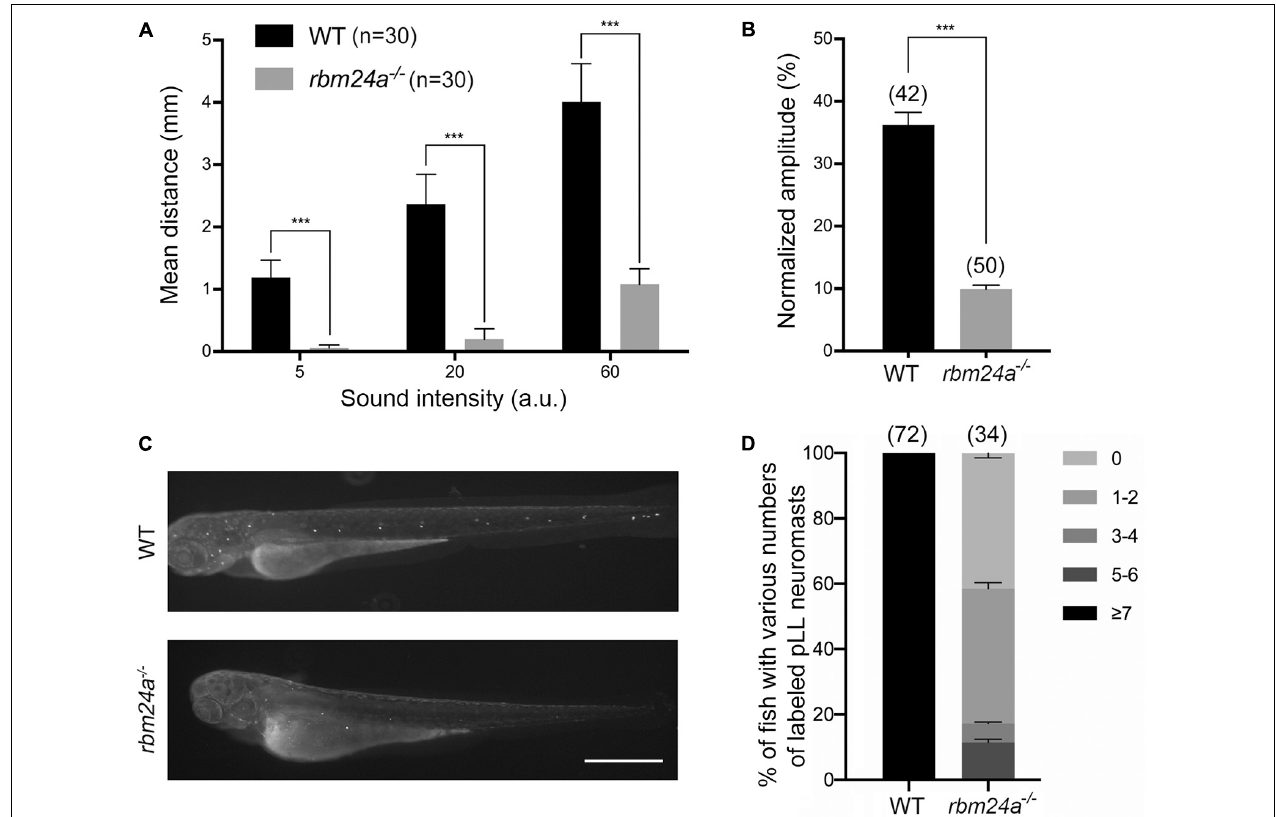
FIGURE 2 | Hair cell function is affected in rbm24a mutants. (A) The auditory function of zebrafish larvae at 5 dpf is evaluated by examining the startle response to various sound intensity. *** p < 0.001. (B) The vestibular function of zebrafish larvae at 5 dpf is evaluated by vestibular head tilt response measurement. *** p < 0.001. (C) The function of hair cells is evaluated by performing FM1-43FX uptake experiment at 3 dpf. Scale bar, 0.5 mm. (D) The numbers of labeled pLL neuromasts per larvae are calculated according to the results from (C) . P value < 0.001. The numbers of larvae for each group are indicated in brackets.